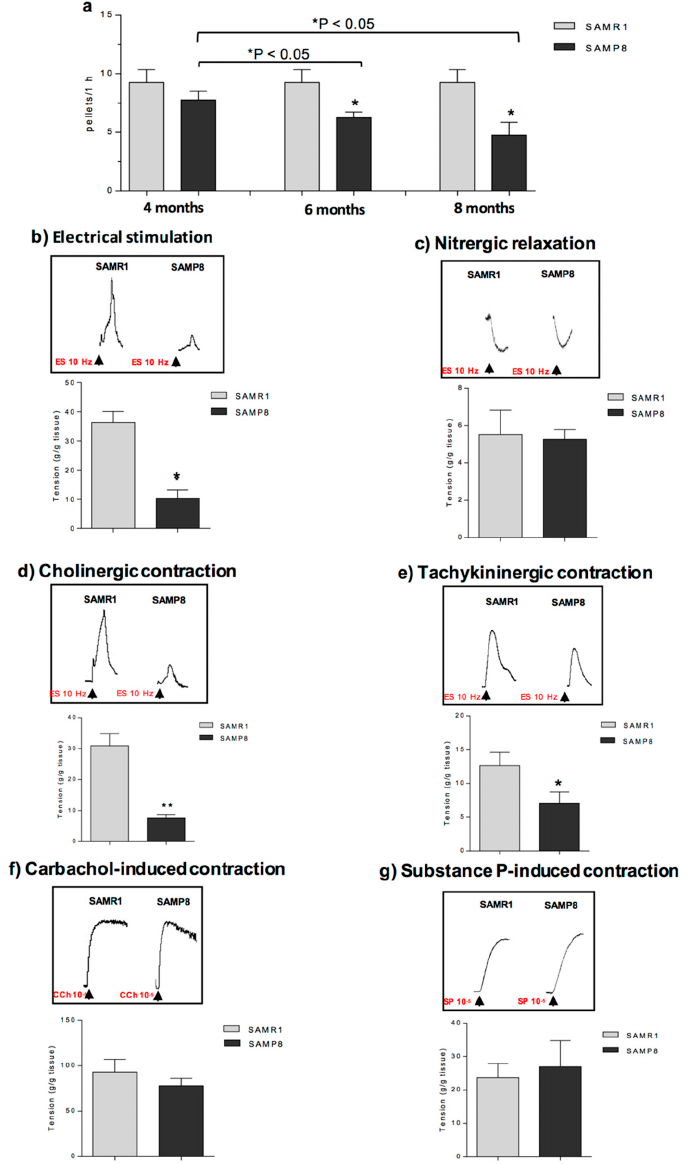
Figure 2. Faecal output and in vitro colonic contractile responses. ( a ) Faecal output expressed as number of pellets in 1 h in SAMR1 or SAMP8 mice at six months of age. Effects of electrical stimulation (ES, 10 Hz) on contractile activity of colonic longitudinal smooth muscle preparations isolated from SAMR1 or SAMP8 mice at six months of age: ( b , c ) colonic tissues maintained in standard Krebs solution; ( d ) colonic tissues maintained in Krebs solution containing L-NAME (100 µ M), guanethidine (10 µ M), L-732,138, (10 µ M), GR159897 (1 µ M) and SB218795 (1 µ M) to record cholinergic contractions; ( e )